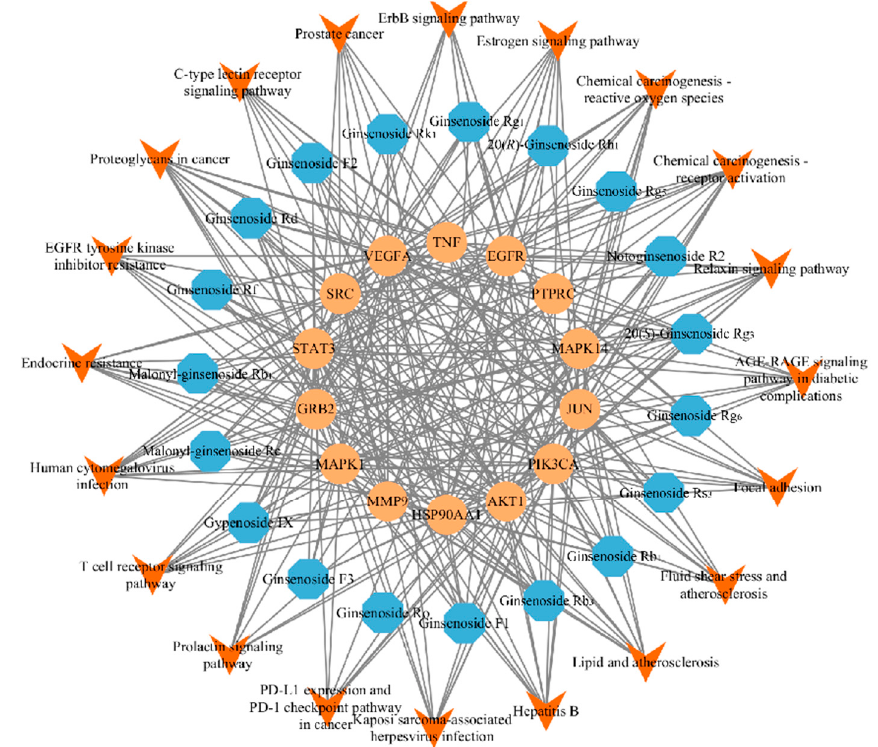
Figure 3 . Protein–protein interaction network. Figure 3. Protein–protein interaction network.